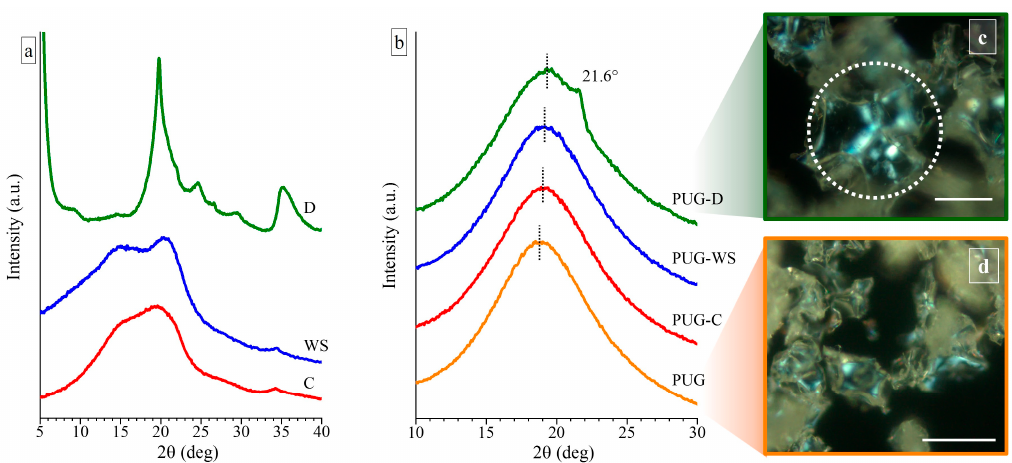
Figure 1. Wide Angle X-ray scattering ( WAXS) profiles of ( a ) the milled cellulose (C), milled walnut shell (WS), and diatomite (D) fillers and of ( b ) the polyurethane composite foams PUG, PUG-C, PUG-WS and PUG-D. Polarized optical microscopy (POM) images of ( c ) the PUG-D and of ( d ) the pristine PUG (d). The scale bar in the POM images is 50 µm.